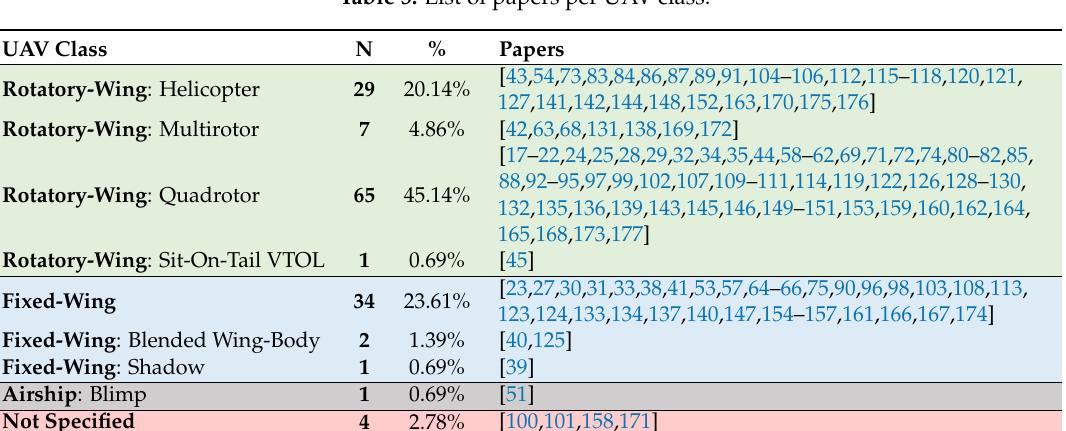
Table 5. List of papers per UAV